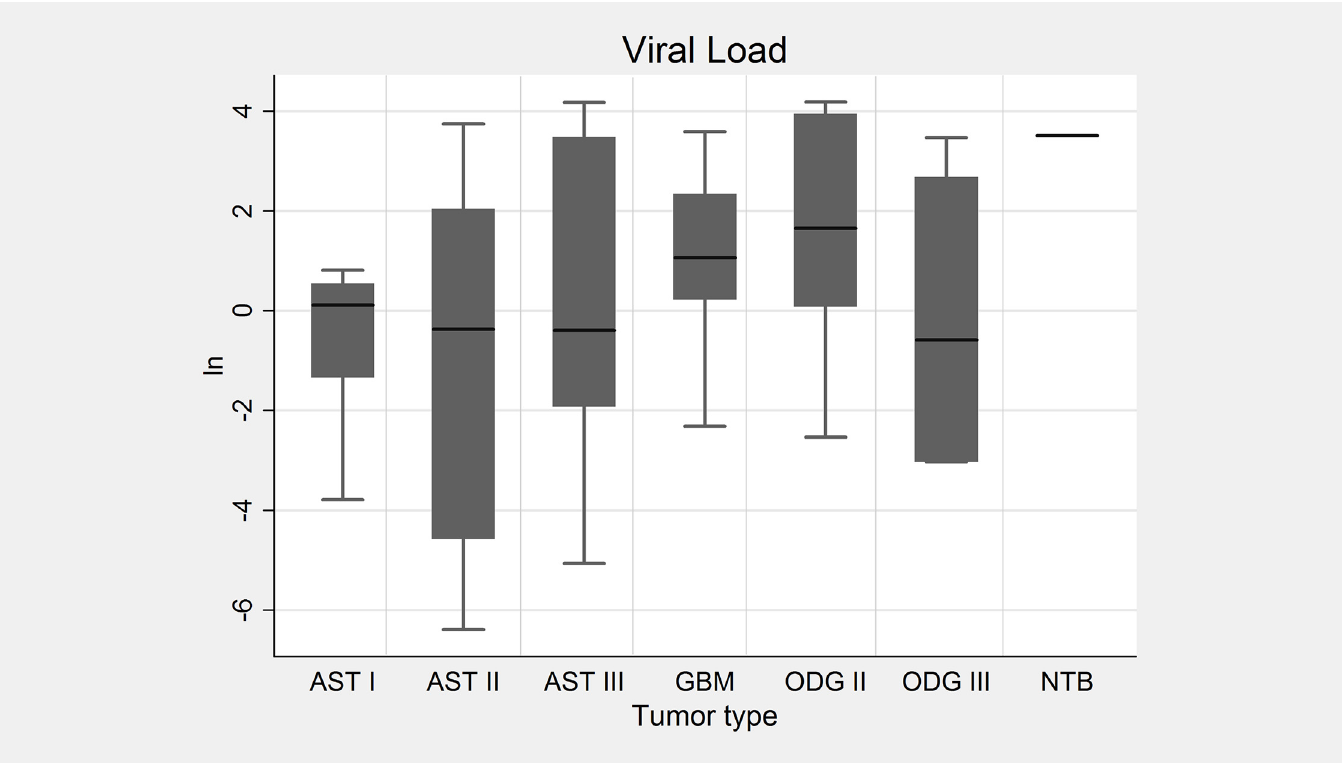
Fig 5. Viral load in gliomas. Box plot of the viral load for astrocytomas (AST), oligodendrogliomas (ODG) and non tumoral brain (NTB), shown as natural logarithm. p-value = 0.0102.